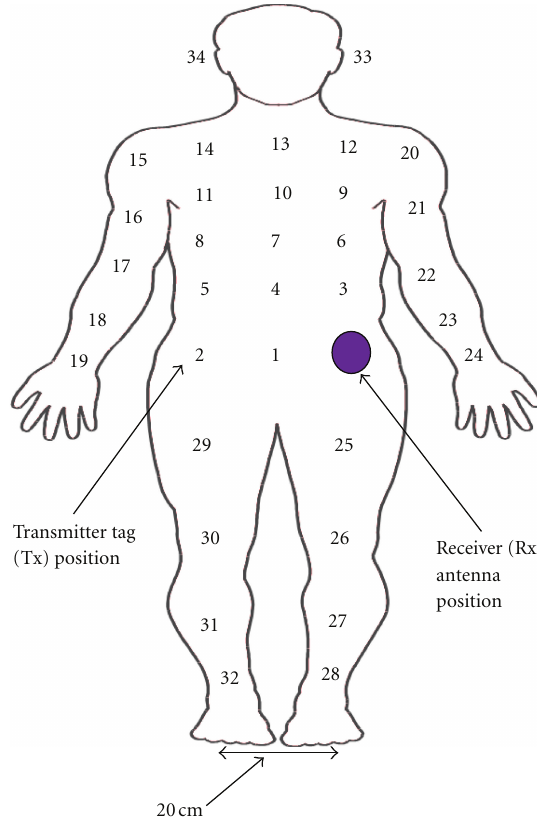
Figure 8: Location of the receiver antenna and positions of the 34 transmitter tags on the human subject.